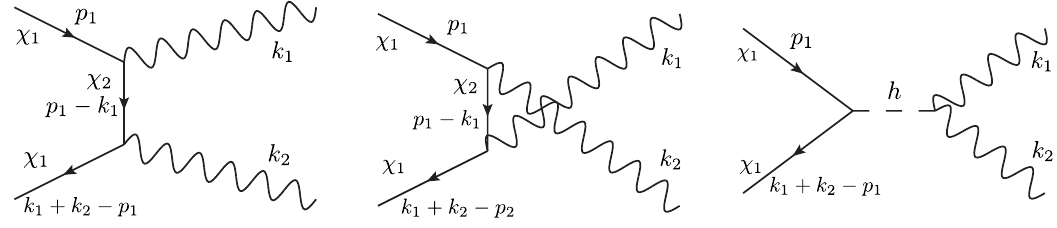
Figure 9 . (cid:31) 1 (cid:31) 1 ! (cid:13) 0 (cid:13) 0 diagrams. Compared with the Higgsless soft-breaking model, the third diagram arises in our